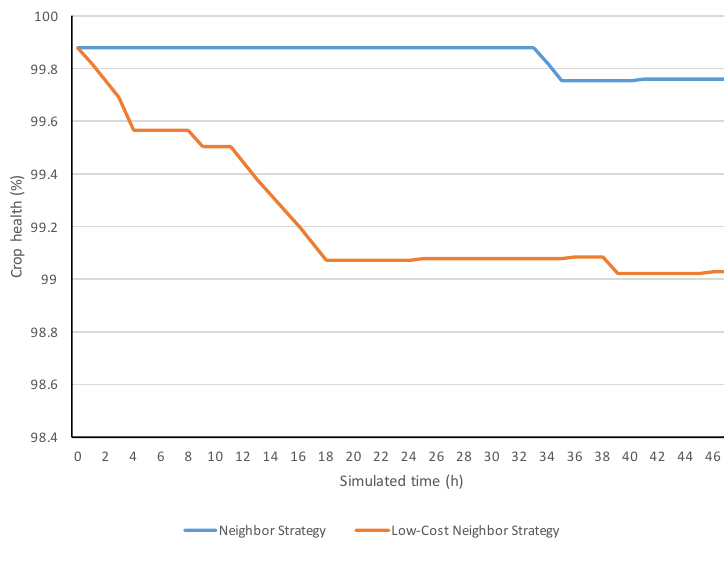
Figure 7. Simulation evolutions of the crop